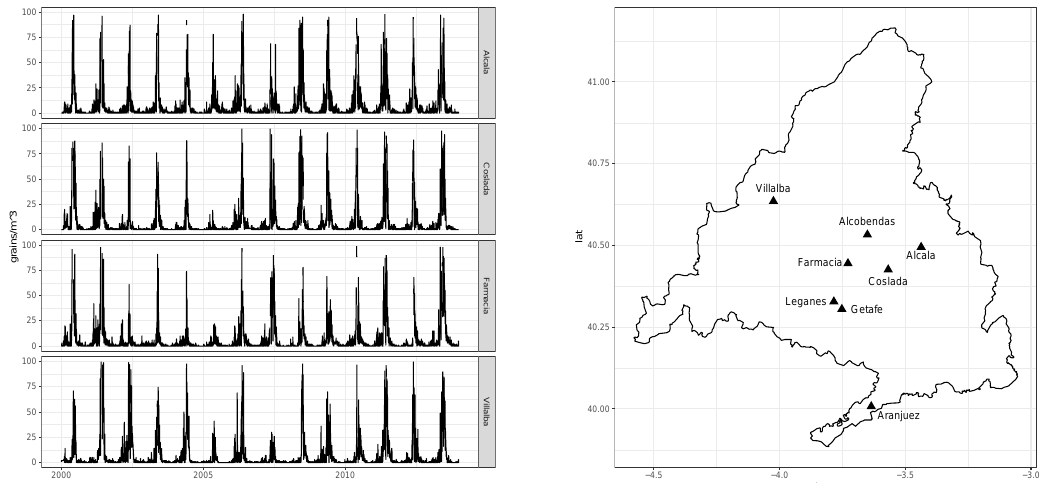
Figure 1. Selected stations with Poaceae pollen concentrations capped at 100 grains/m 3 ( left ). Distribution of the locations in the region of Madrid ( right